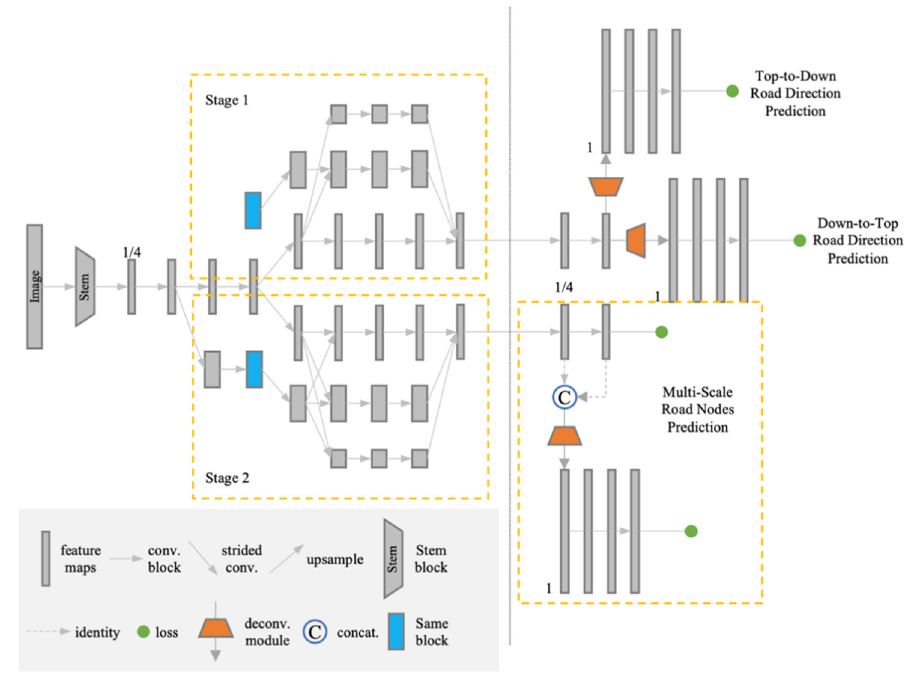
Figure 2. Overview of the proposed framework, Bi-HRNet. The Bi-HRNet contains three parts: top-to-down road direction prediction, down-to-top road direction prediction, and multi-scale road node prediction.